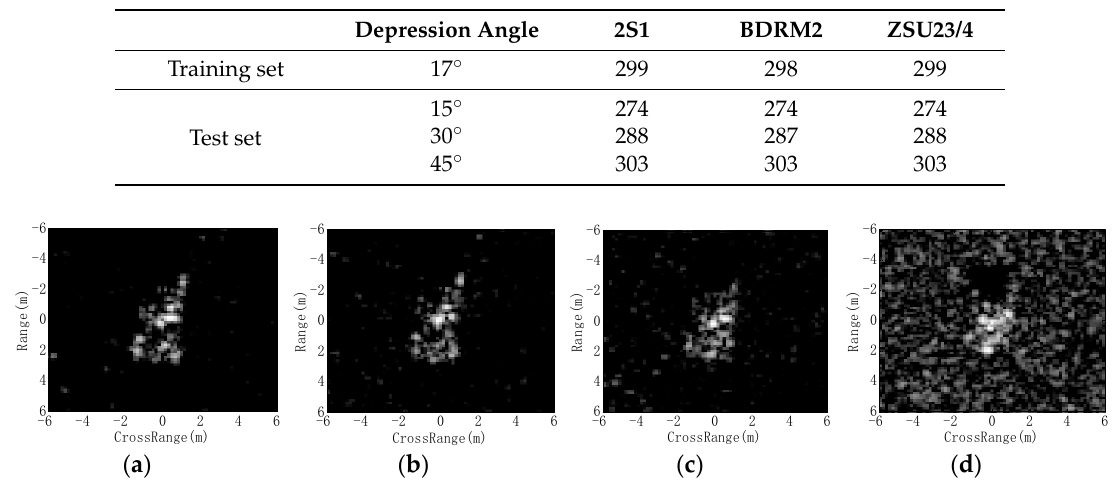
Table 7. Dataset with depression angle variance.